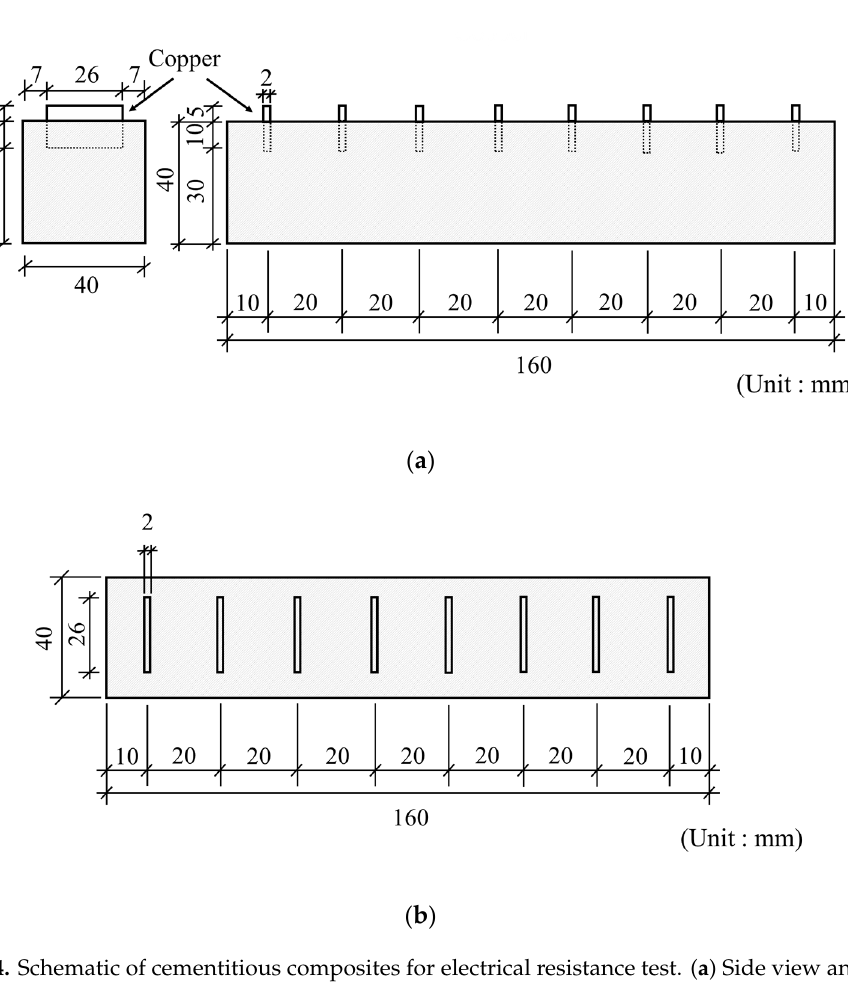
Figure 4. Schematic of cementitious composites for electrical resistance test. ( a ) Side view and front view, and ( b ) plan view.